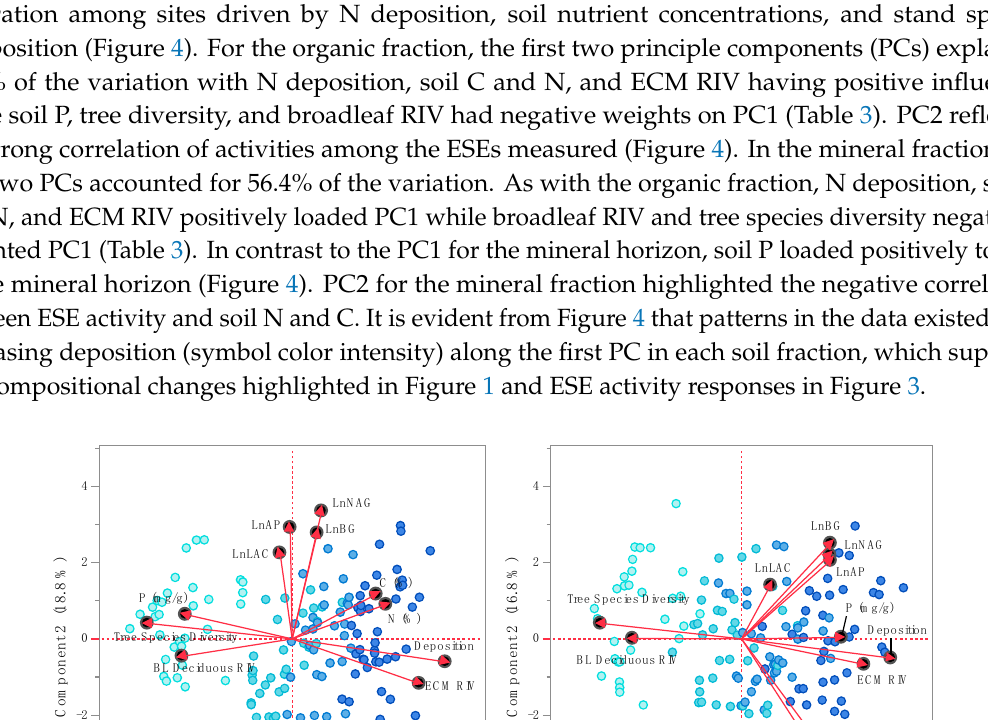
Table 2. Parameter estimates for multiple linear regression of soil-level and plot-level predictors of ESE activities.